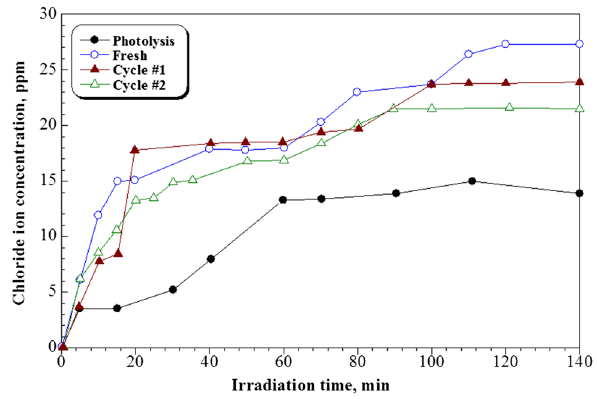
Fig. 9 Chloride ion formation in the irradiated solution during direct photolysis, photocatalytic degradation and re-use using TiO 2 sup- ported on alumina